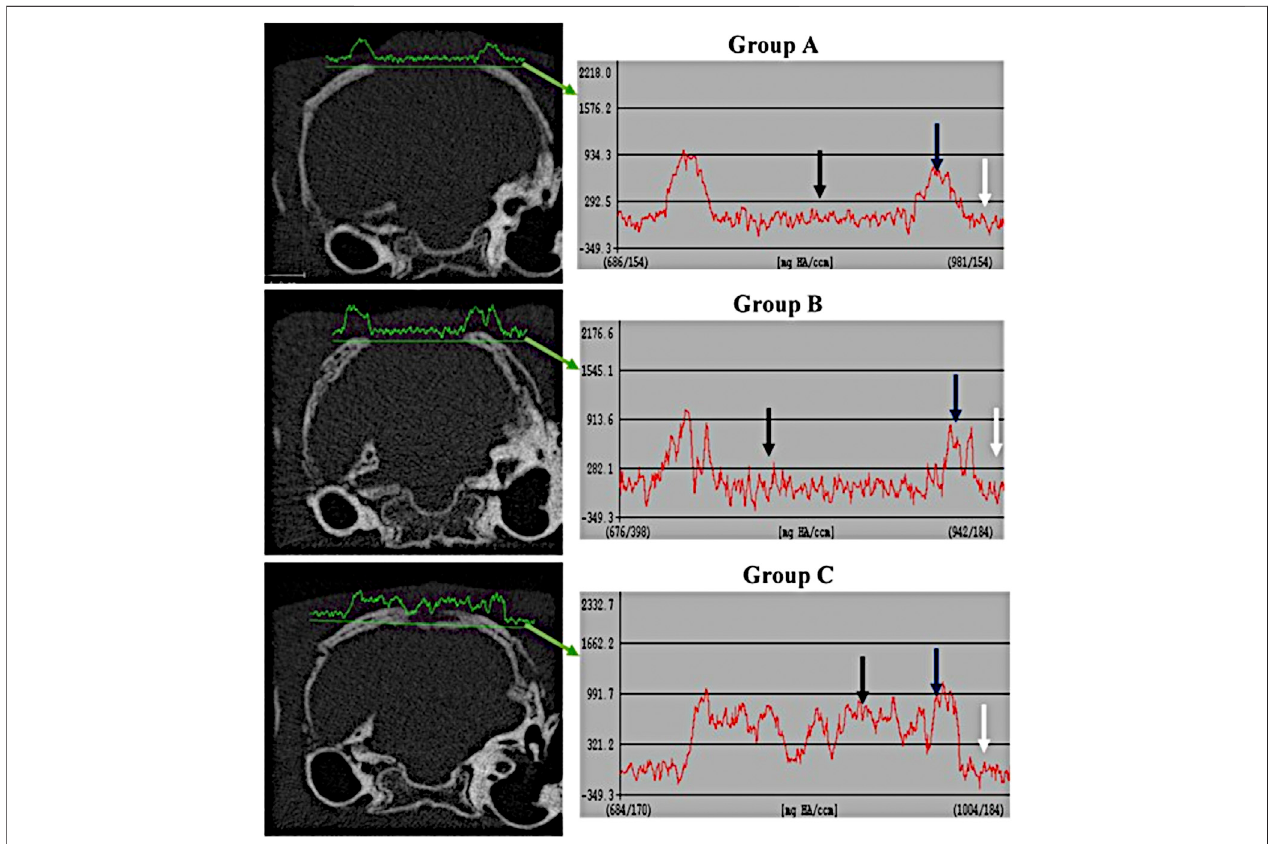
FIGURE3| Comparisonoftissuedensity ofthehealingsurgicaldefectsbetweengroups(groupA(control),groupB(chitosangel),groupC(OPG-chitosangel)).at 6 weeks of treatment. Soft tissue at the periphery (white arrows); Normal bone (blue arrows); Center of defect (black arrows).